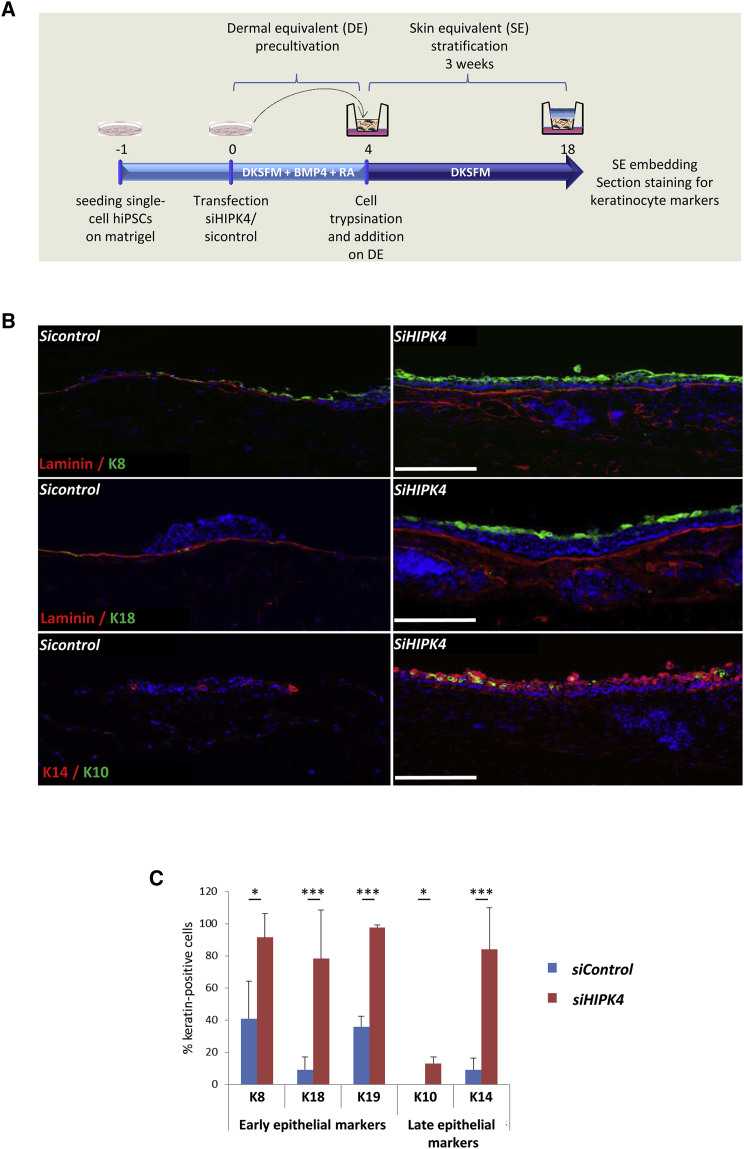
HIPK4 Silencing Promotes the Differentiation of Epithelial Precursors in Organotypic Cultures(A) Schematic overview of the organotypic culture (OTC) protocol. hiPSC D1 were differentiated for 4 days and included in a 3D co-culture with human dermal fibroblasts for 3 weeks.(B) Immunostaining against Laminin β1 and K8, K18, K10, and K14 in paraffin sections of 3-week-old OTCs from either HIPK4 siRNA (siHIPK4) or a non-targeting siRNA (siControl) transfected cells. Scale bar, 100 μm.(C) Graph showing quantification of keratin-positive cells as a percentage of the total epithelial cells. Antibodies against K14, K10, K19, K8, and K18 were used. Data represent the mean of three independent experiments ± SEM. Statistical analysis was performed using unpaired Student's t test (∗p < 0.05, ∗∗∗p < 0.001).